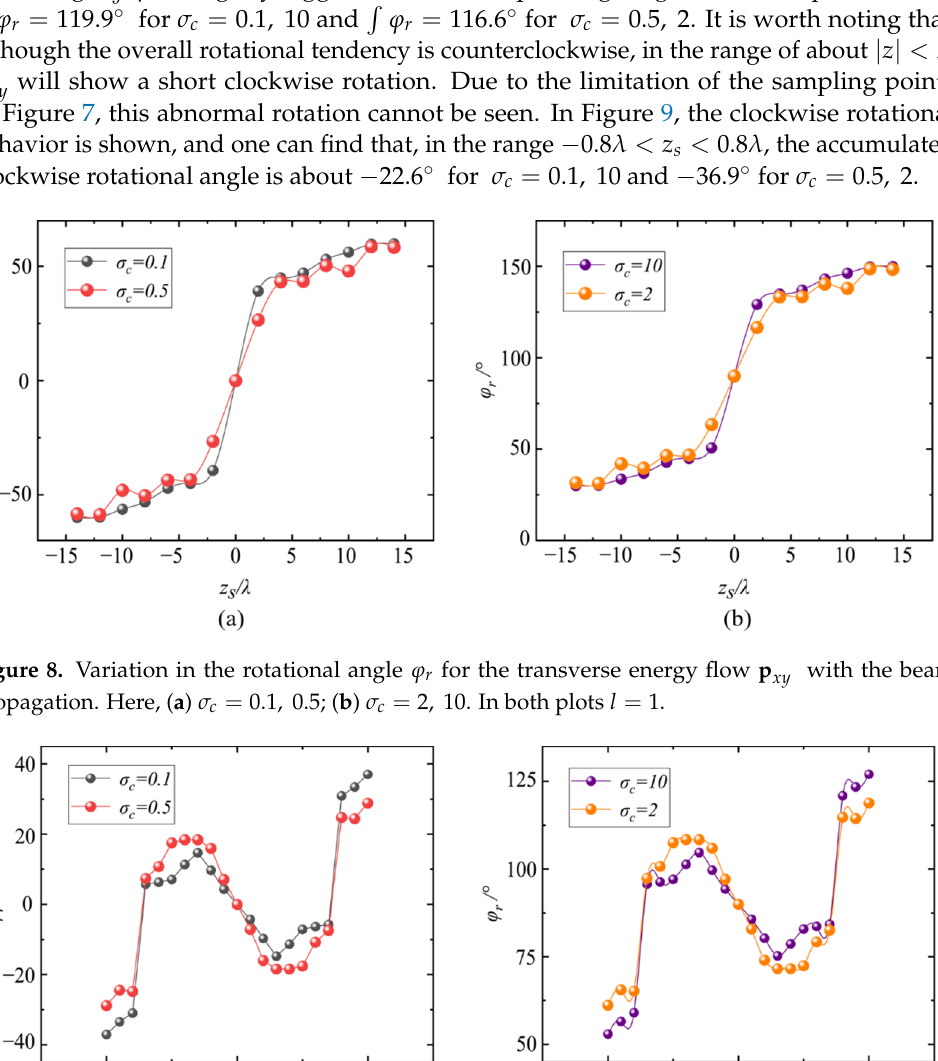
Figure 9. Same as Figure 8, but with more details in a narrower range ( − 2 λ < z s < 2 λ ).